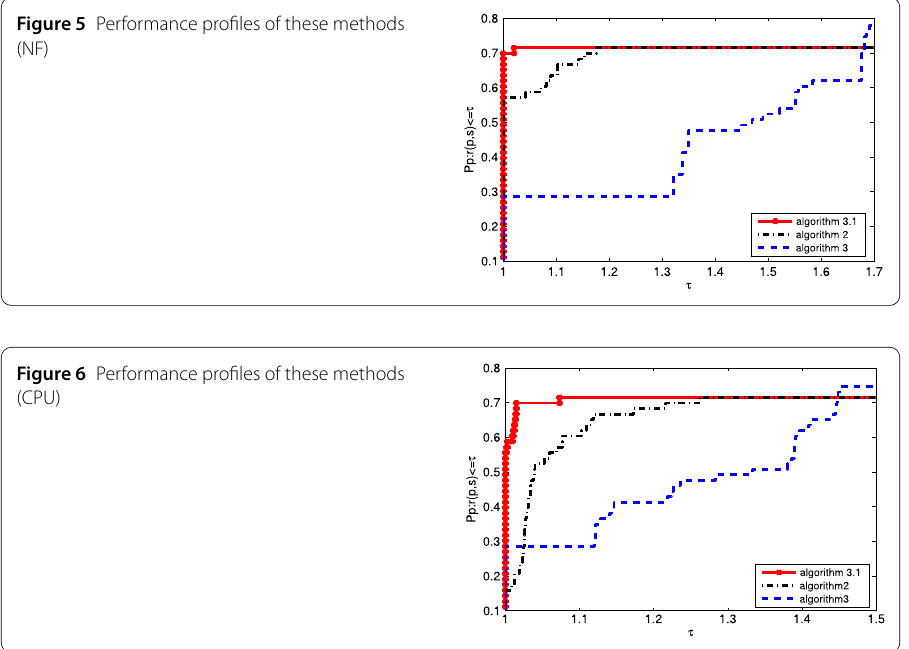
Figure 6 Performance profiles of these methods